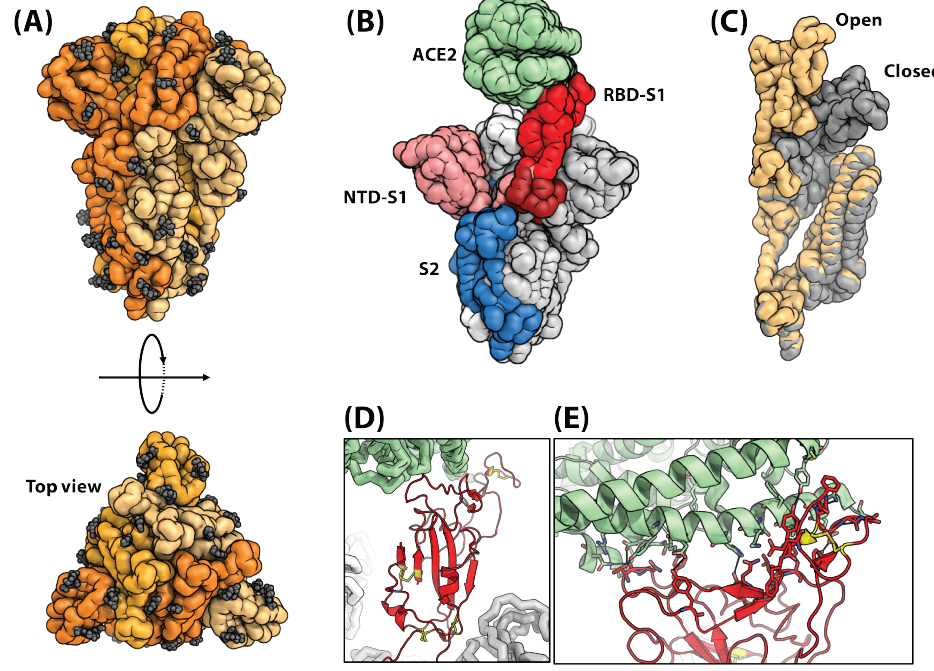
Figure 3. ( A ) Structure of SARS-CoV-2 S protein (PDB ID: 7FCE [45]). The glycosylations are shown as black spheres on the surface of the protein. There are > 20 glycosylation sites in the S protein [46]. ( B ) RBD domain is in charge of binding to ACE2 (PDB ID: 7A97 [47]). ( C ) The S protein can adopt a closed conformation (PDB ID: 7FCE) or an open conformation (PDB ID: 7A97). The open conversation is the one that can engage with ACE2. ( D , E ) show the binding interaction of the RBD domain with ACE2. The yellow color indicates disulfide bonds. The dashed lines in E are hydrogen